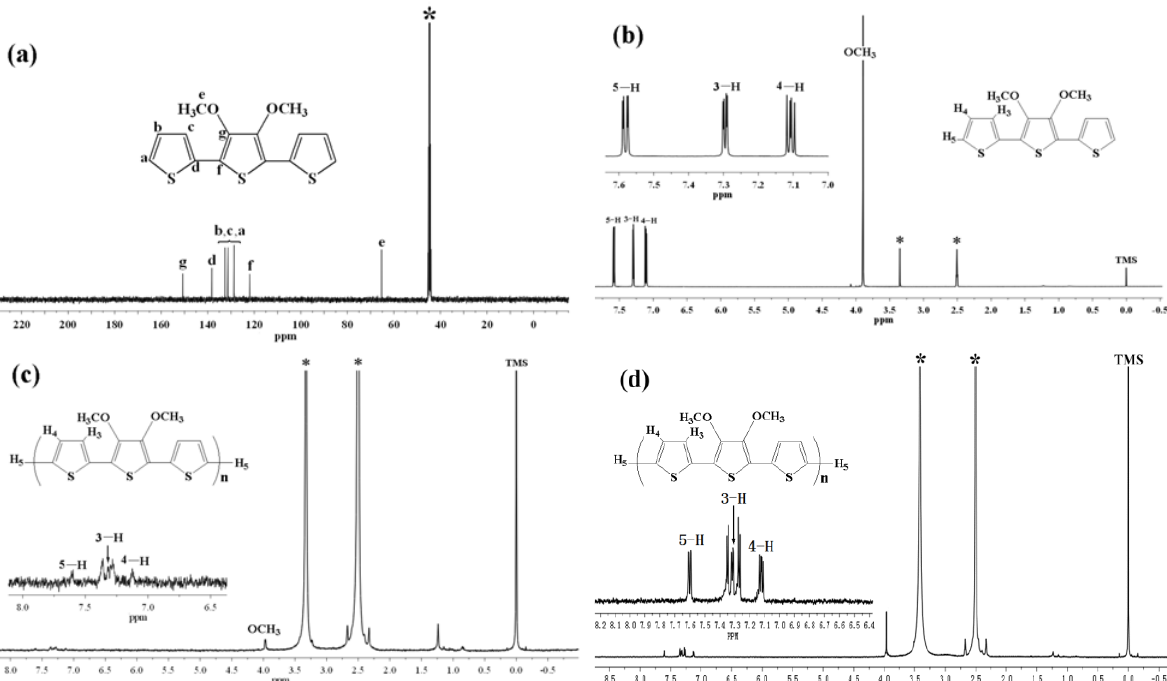
Figure 1. 13 C-NMR spectrum and 1 H-NMR spectra of monomer and polymer: ( a ) 13 C-NMR spectra of TMT in DMSO-d ; ( b ) 1 H-NMR spectra of TMT in DMSO-d 6 ( c ) poly (TMT) in DMSO-d ; ( d ) undoped poly (TMT)3 in DMSO-d 3 6 comes from H O and DMSO-d 2 6